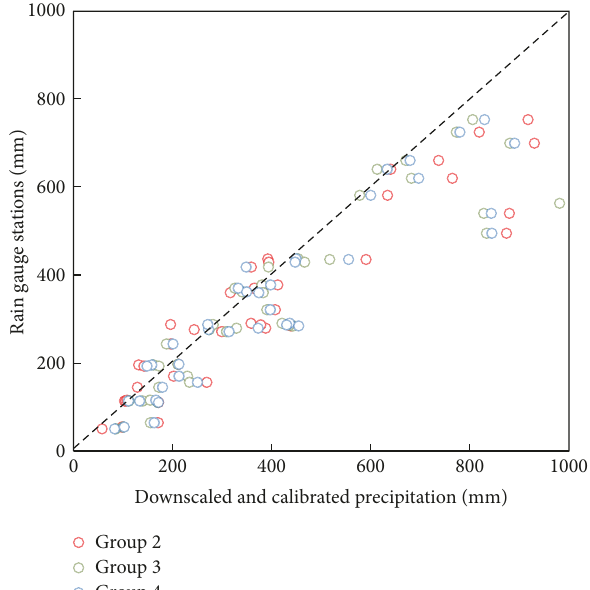
Figure 9: Scatterplot of the measured precipitation from 10 independent rain gauge stations versus the estimated precipitation according to Groups 2, 3, and 4.